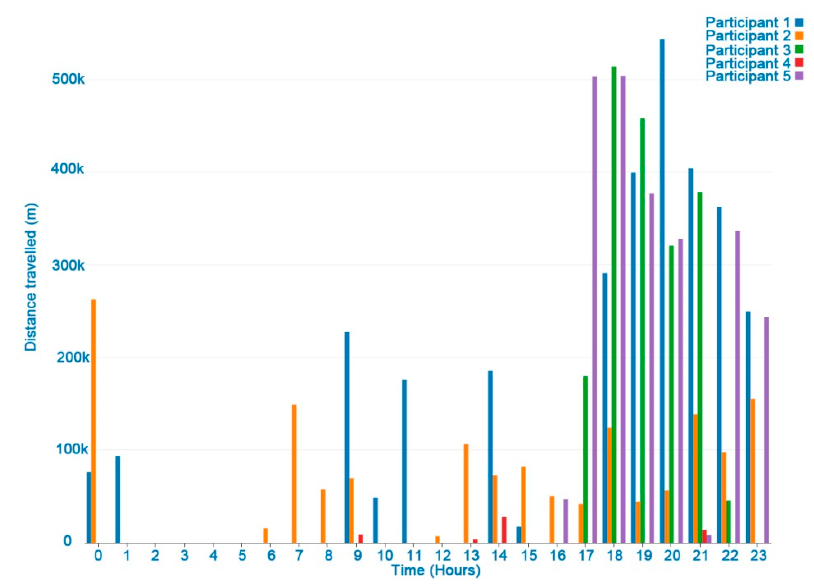
Figure 6. Distance travelled by participants (m) in a day of HDRS monitoring.